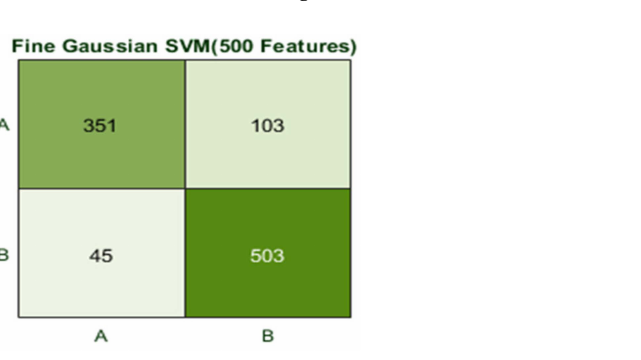
Figure 18. Confusion matrix for FG(SVM) with 500 features and using 10-fold results.